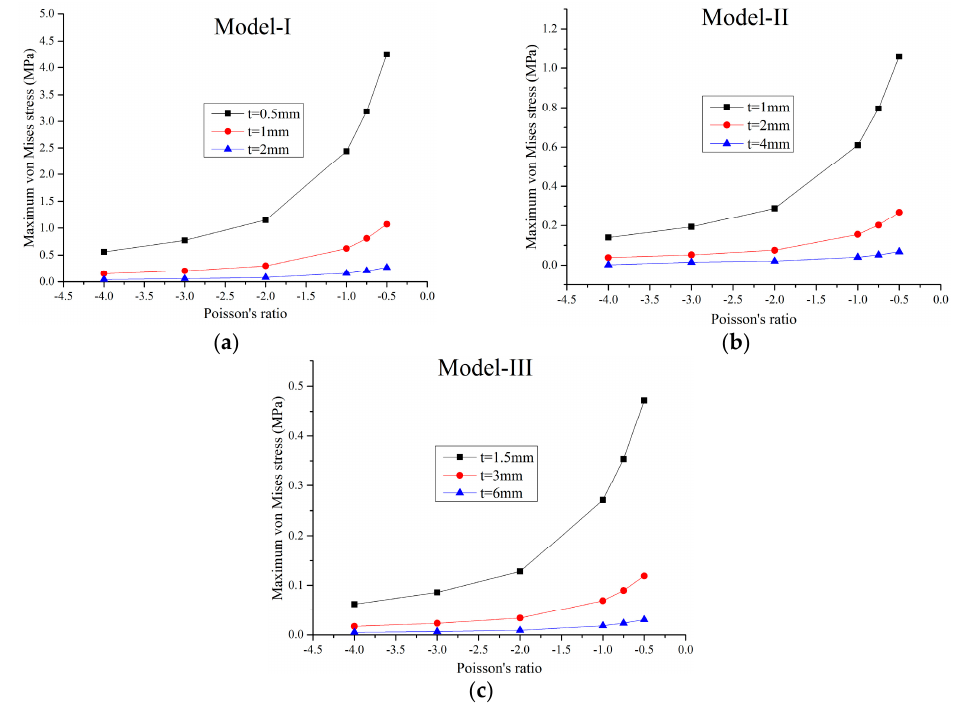
Figure 5. Maximum von Mises stress versus the Poisson’s ratio: ( a ) Model-I; ( b ) Model-II; ( c ) Model-III.